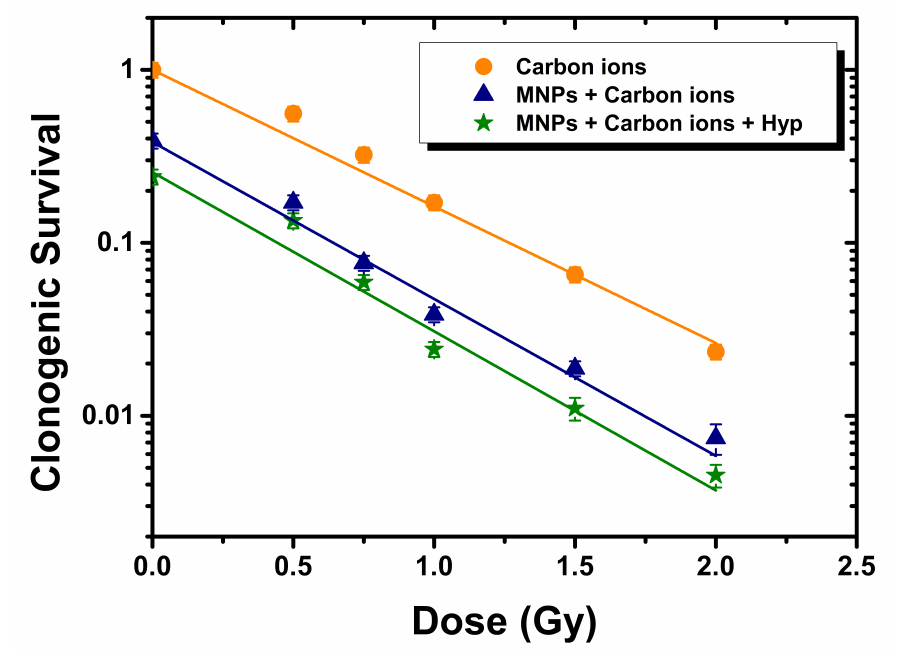
Figure 4. Clonogenic survival of BxPC3 cells culture for 3 di ff erent protocols (see text): hadron therapy (HT) only (orange circles), HT + MNPs administration (navy triangles) and HT + MNPs administration + Hyp (green stars). An additive e ff ect of MNPs and Hyp is noted. Solid lines represent the best fit of the clonogenic survival (CS) curves as a function of the radiation dose D according to the law CS ∝ exp(– α D). From the fits: α C ions = 1.82 ± 0.06 Gy − 1 ; α MNPs + C ions = 2.09 ± 0.15 Gy − 1